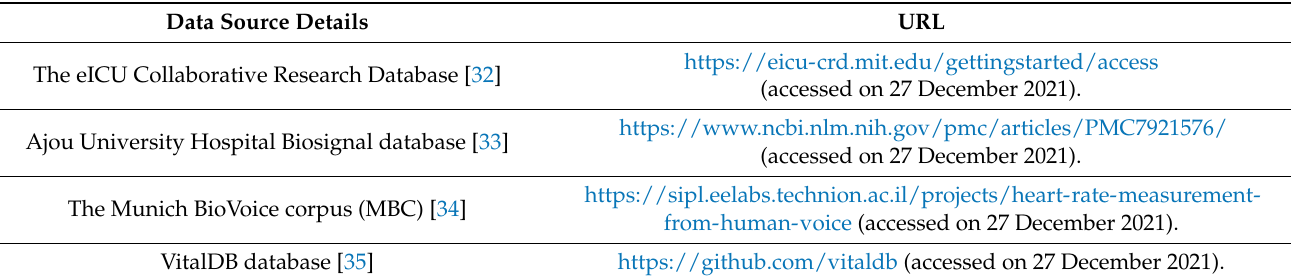
Table 1. The different data sources of medical applications using